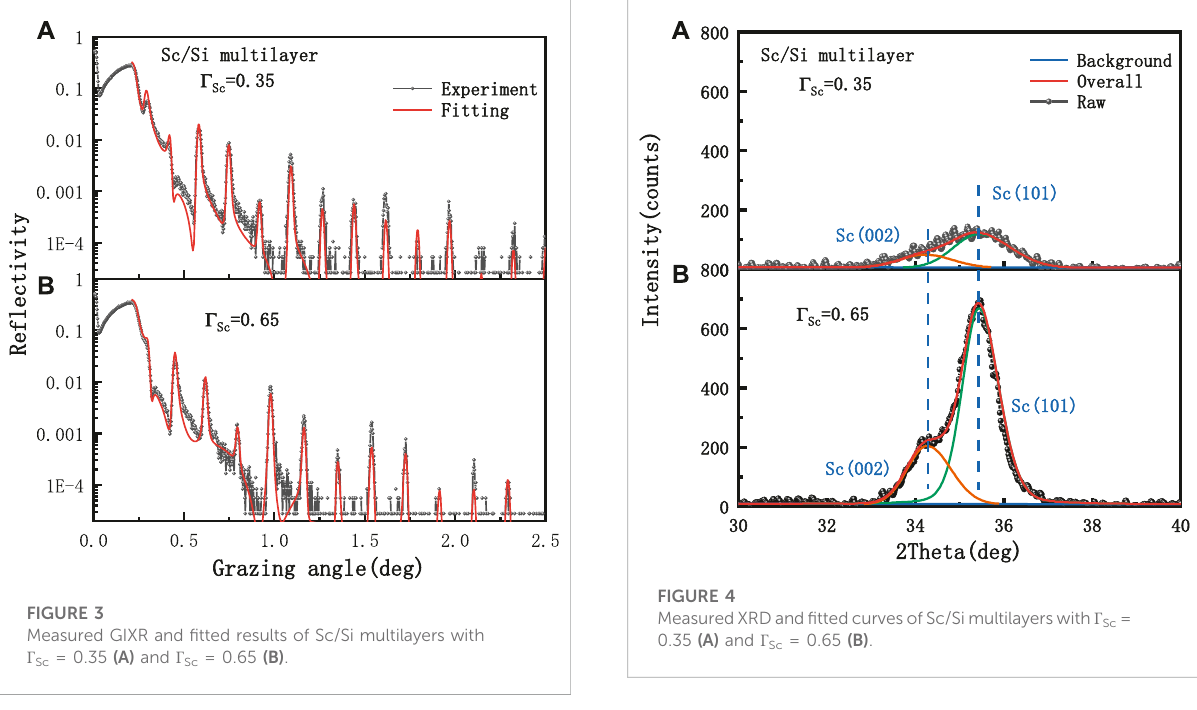
TABLE 1 Sc/Si multilayer fi tted parameters deduced from GIXR measurements. Ratio Layers Thickness/nm Roughness/nm Ratio Layers Thickness/nm Roughness/nm Γ Sc = 0.35 SiO 2 1.60 0.48